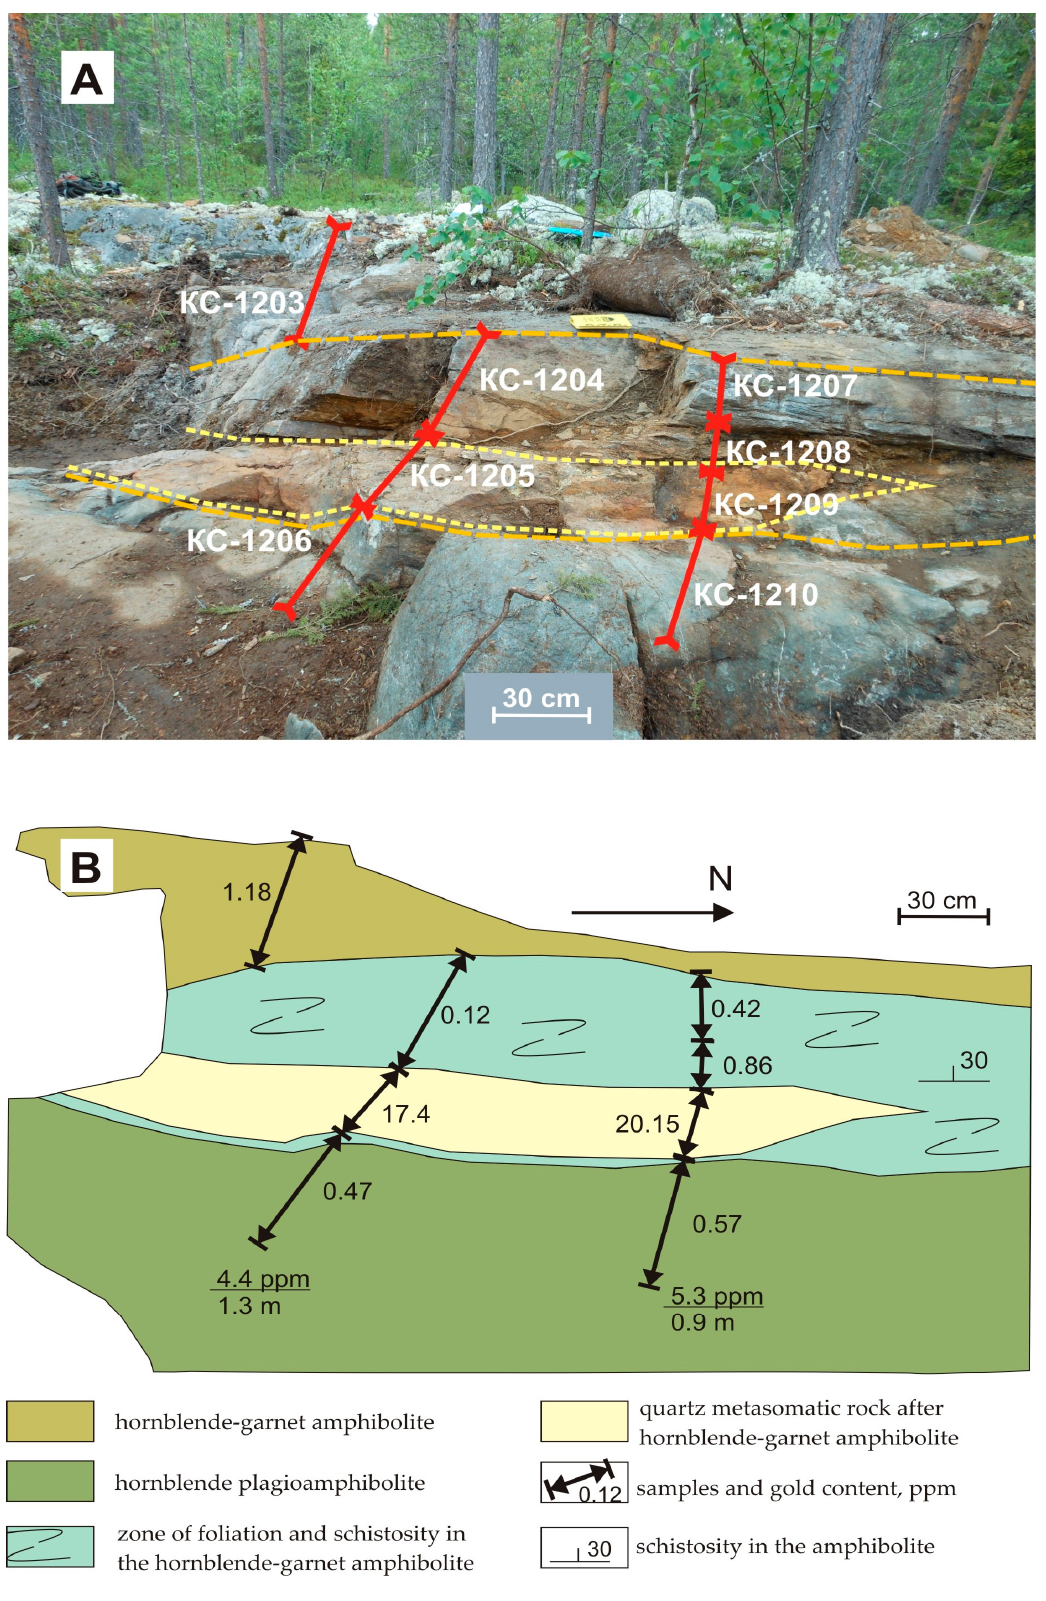
Figure 13. The Kichany gold occurrence. ( A ) Photo of the outcrop, with location of trench samples; ( B ) documentation of the same outcrop, with the results of assaying for gold. Gold forms inclusions in silicate minerals (hornblende, oligoclase, titanite) in quartz, then it was noted at the boundary of sulfides (arsenopyrite and marcasite) with quartz, and less frequently, in inclusions in pyrrhotite and chalcopyrite (Figure 14).